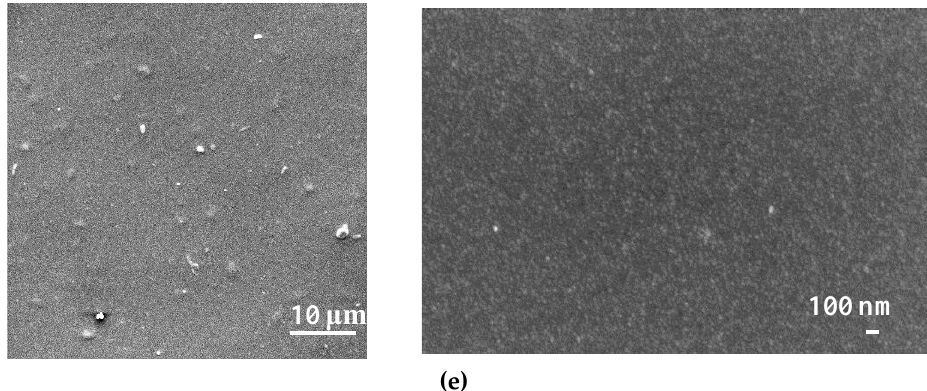
Figure 4. SEM micrographs of the surfaces of the selective layer of TFC and TFN membranes at lower and higher magnification: ( a ) D30; ( b ) D30-IP; ( c ) D30-IP1; ( d ) D30-IP3; ( e ) D30-IP5.